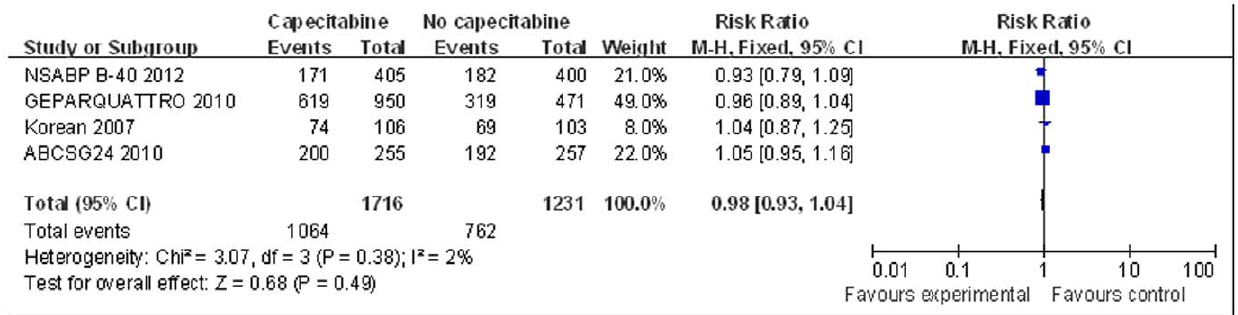
Figure 5. Forest plot to meta-analyze BCS outcomes for neoadjuvant therapy with or without capecitabine.